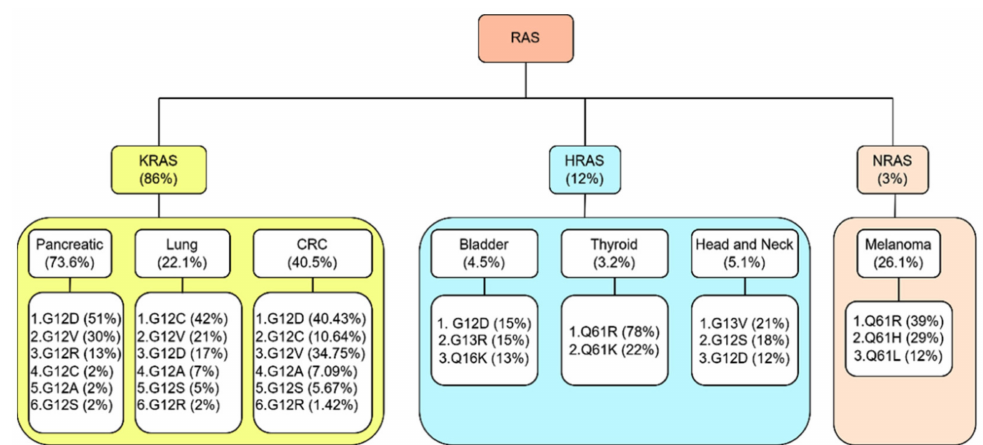
Figure 2. Frequency of KRAS , HRAS, and NRAS in different types of cancer